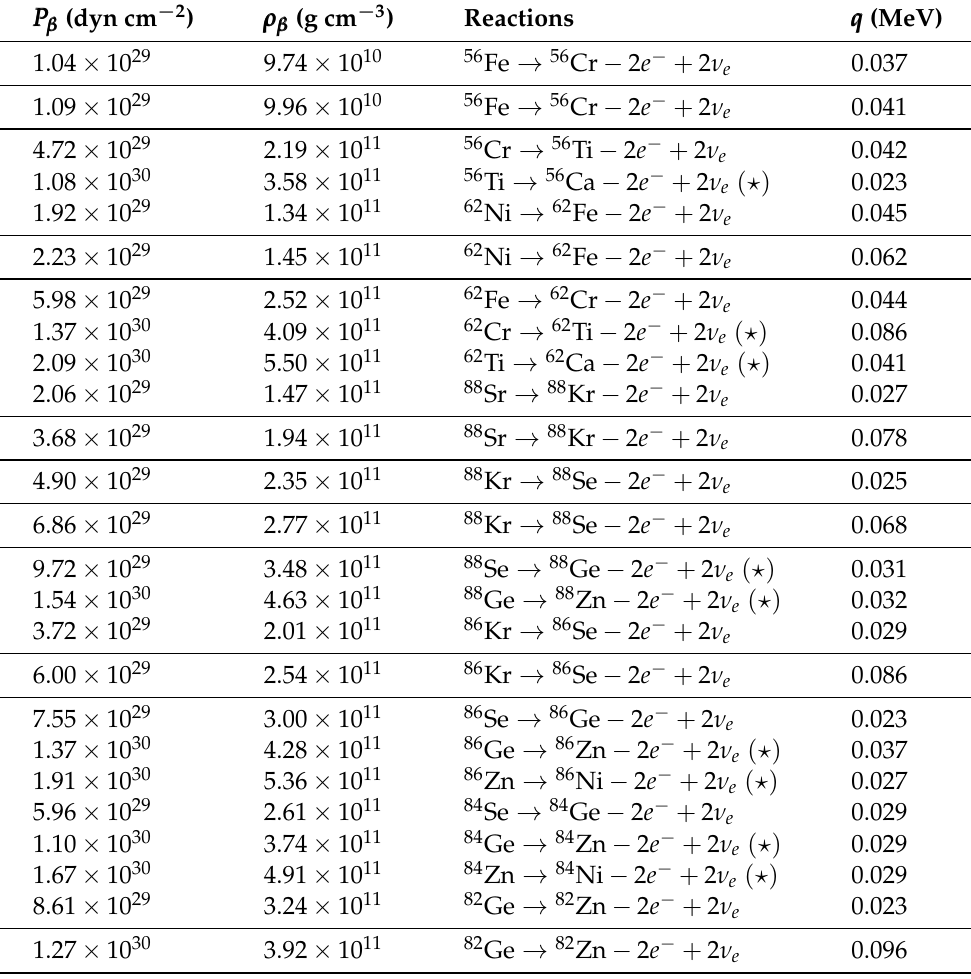
Table 2. Same as Table 1, but for B (cid:63) =